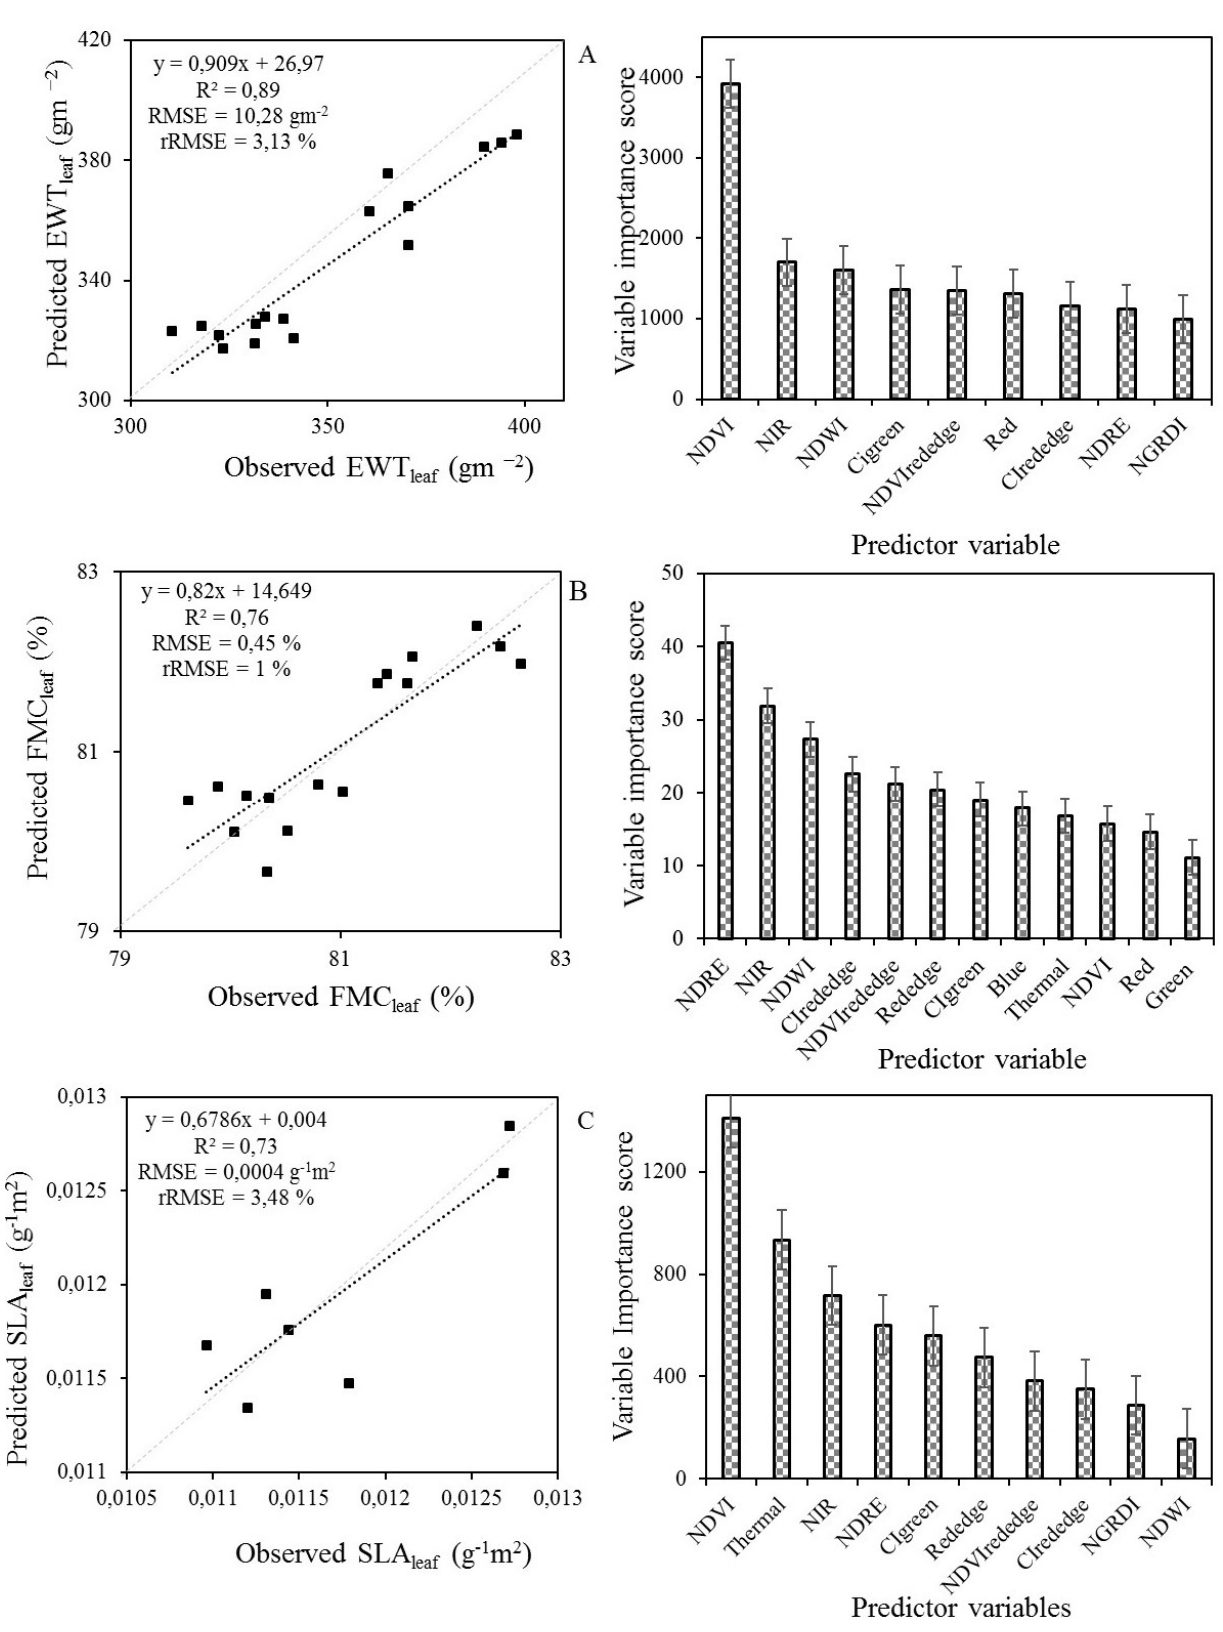
Figure 3. Relationship between the predicted and observed ( A ) EWT leaf , ( B ) FMC leaf , and ( C ) SLA leaf of maize derived using optimal predictor variables and the model variable importance